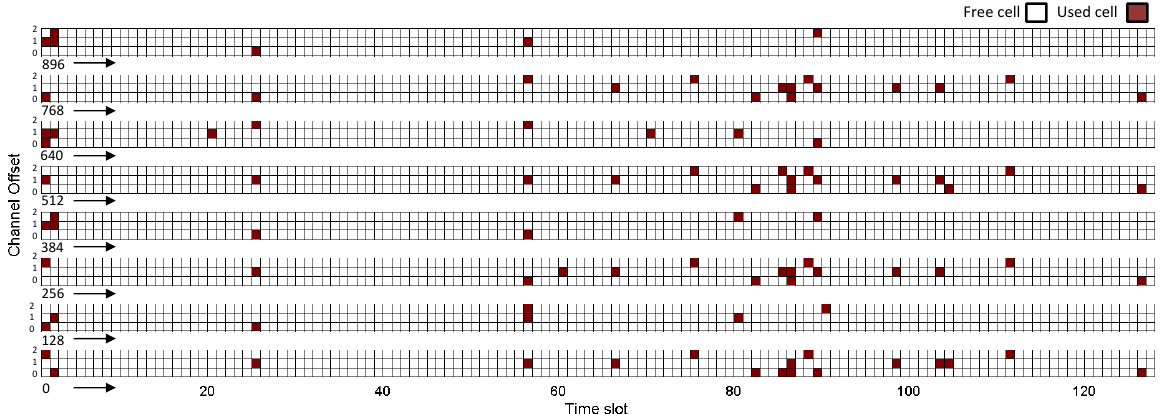
Used cellFree cell